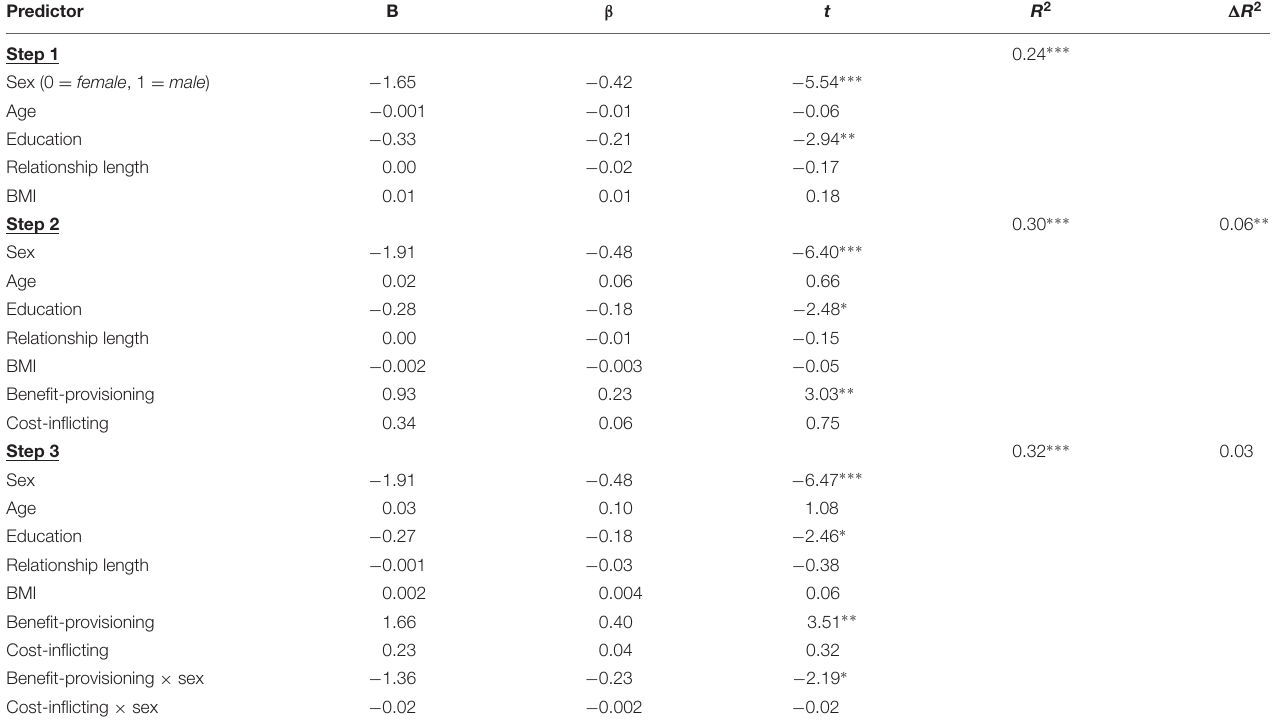
TABLE 2 | Results of moderated regression analyses.